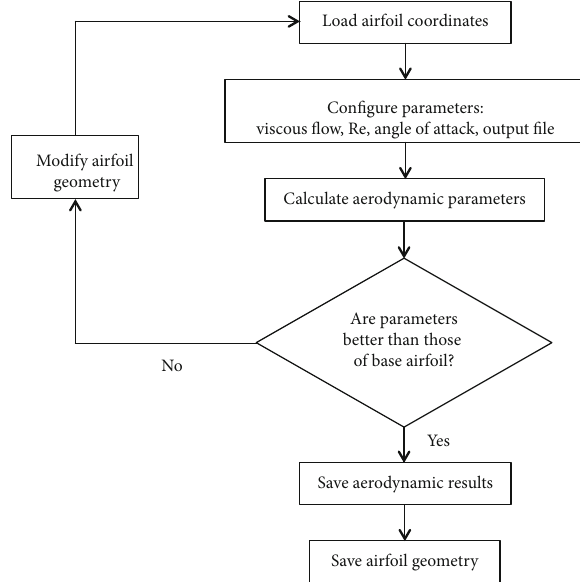
Figure 1: Summary of XFOIL procedure for airfoil